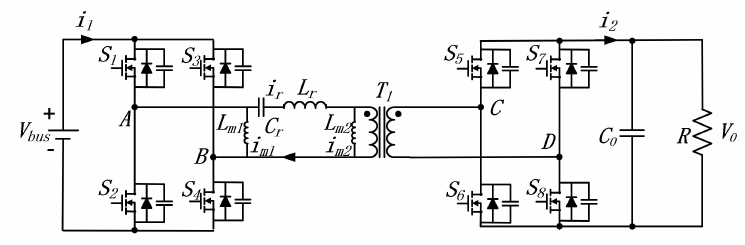
Figure 2. Bidirectional LLC resonant